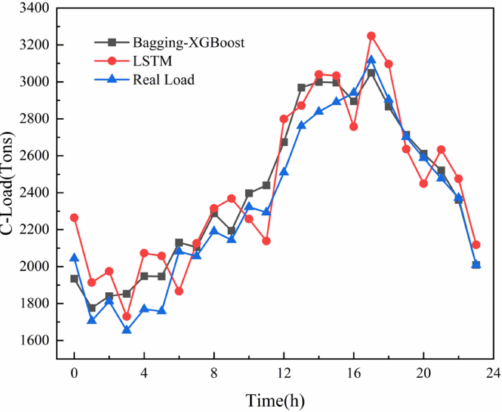
Figure 12. Cooling load forecast results. Cooling load forecasting results compared with LSTM.